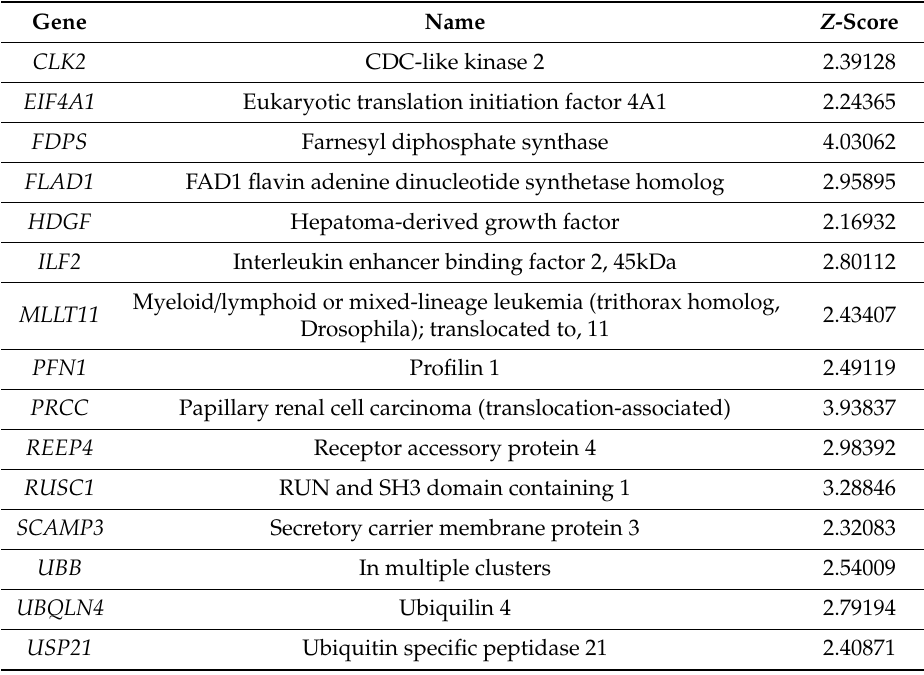
Table 2. Enhancer regulated genes present in the PRECOG database with z-score greater than 1.96. Z -scores of these genes were taken from the PRECOG